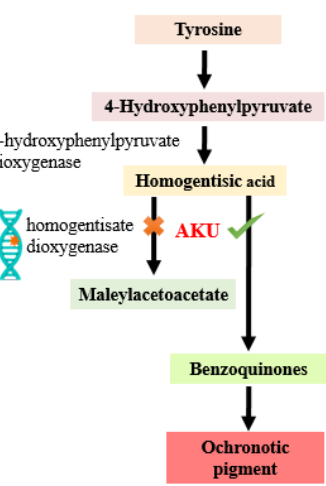
Figure 1. Metabolic error in Alkaptonuria (AKU). In AKU, the gene encoding homogentisate dioxygenase is mutated thus converting homogentisic acid to benzoquinones and producing bluish-black pigment in connective tissues, also known as ochronotic pigment.